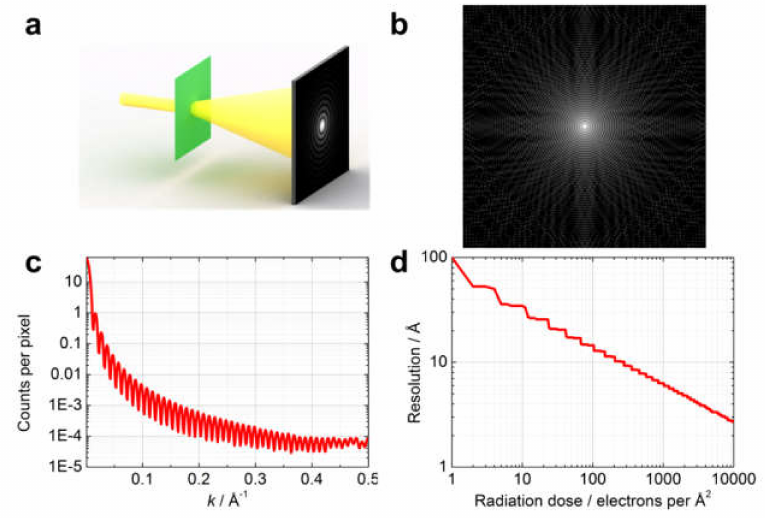
Figure 29. Radiation dose required to achieve a given resolution in CDI. ( a ) Experimental arrangement for CDI. ( b ) Simulated di ff raction pattern of a round phase object of 10 nm in diameter. ( c ) Angular-averaged radial profile of a di ff raction pattern simulated at a dose of 1 electron per Å 2 . ( d ) Resolution as a function of radiation dose in